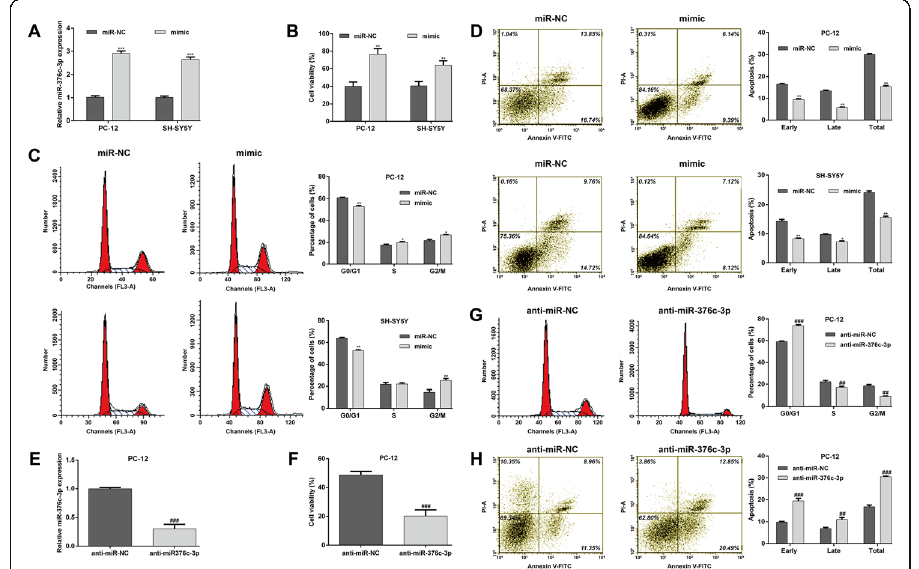
Fig. 2 MiR-376c-3p attenuated OGD-induced cell injury. PC-12 and SH-SY5Y cells were transfected with miR-376c-3p mimic or miR-NC and then subjected to OGD. ( a ) Quantitative reverse transcription PCR analysis of miR-376c-3p expression in PC-12 and SH-SY5Y cells. ( b ) Cell viability was measured using the CCK-8 assay. ( c ) Cell cycle distribution was analyzed via flow cytometry with PI staining. ( d ) Cell apoptosis was examined using flow cytometry with Annexin V/PI double staining. ( e ) The expression of miR-376c-3p was analyzed in PC-12 cells after transfection with anti-miR-376c-3p or anti-miR-NC. ( f ) Cell viability was measured in PC-12 cells. ( g ) Cell cycle distribution was analyzed using flow cytometry with PI staining in PC-12 cells. ( h ) Cell apoptosis was examined using flow cytometry with Annexin V/PI double staining in PC- 12 cells. Data are expressed as means ± SD. * p < 0.05, **p < 0.01, ***p < 0.001 vs. miR-NC; ## p < 0.01, ### p < 0.001 vs.